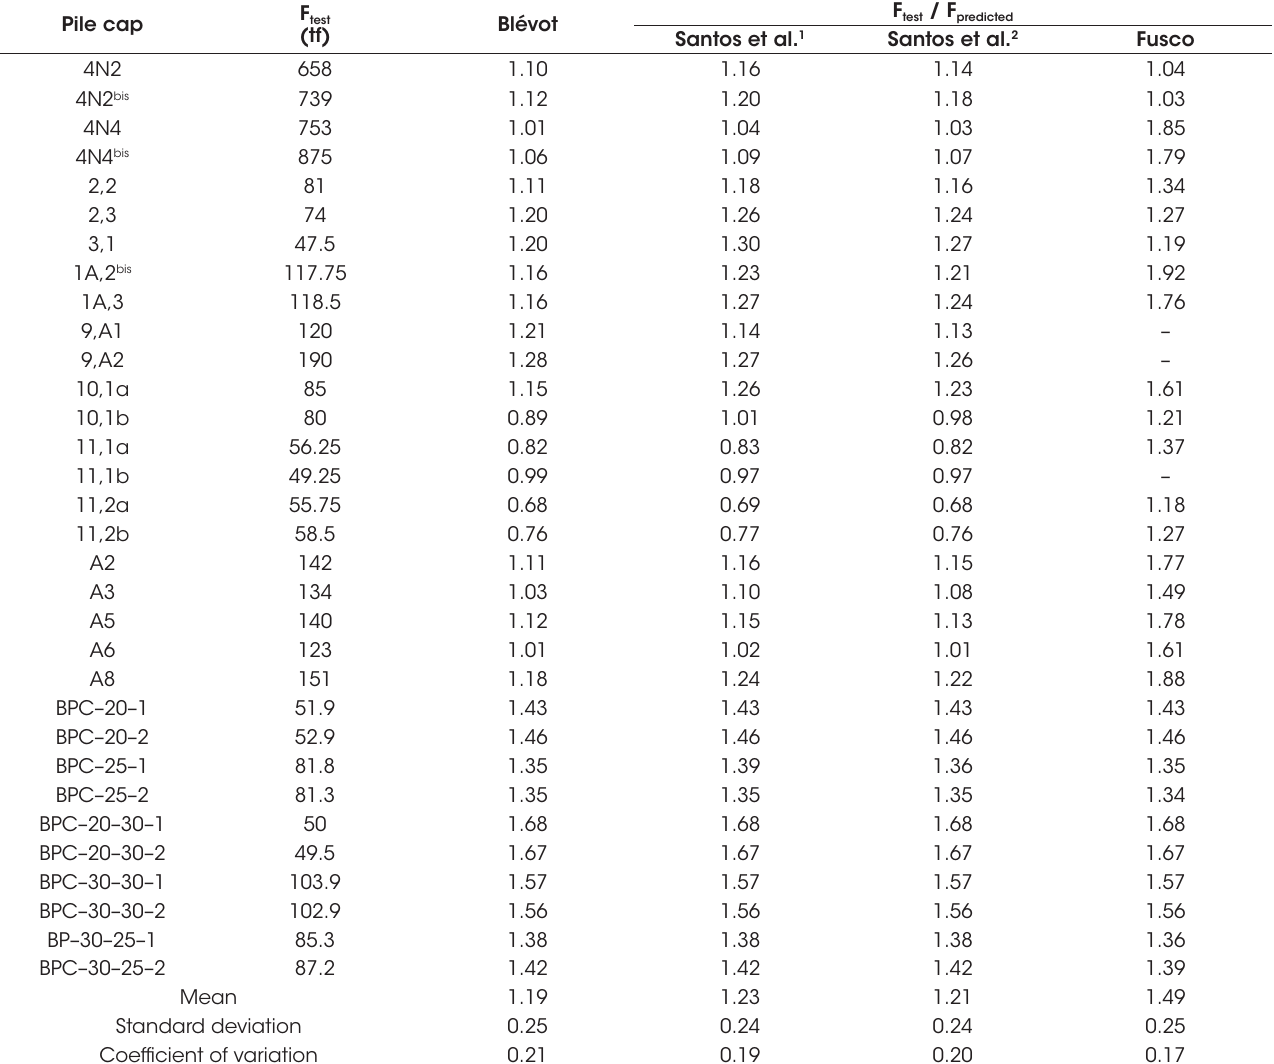
Comparisons between Blévot, Fusco e Santos et al. predictions and experimentally observed failure